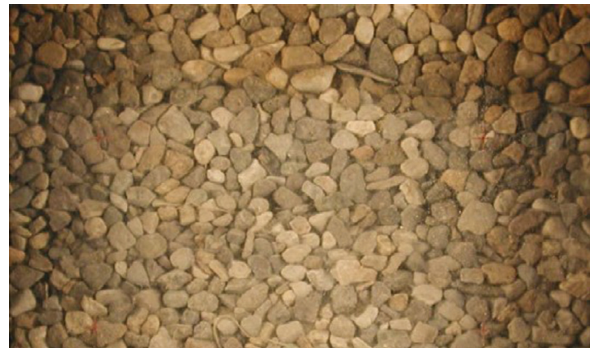
Figure 2: Photograph of the experimental angular gravel sample (Zhang